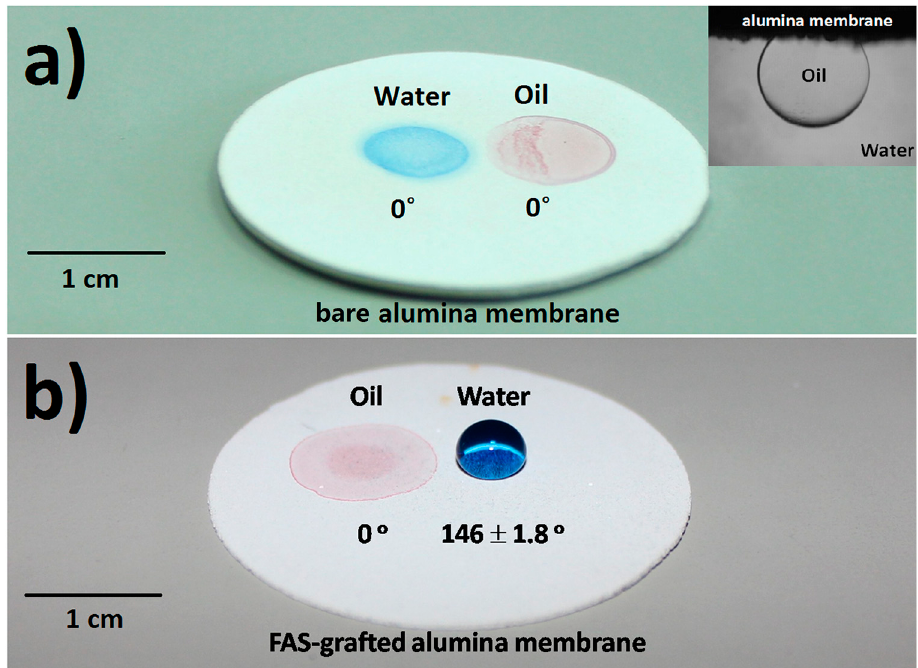
Figure 3. Wetting behavior of water and oil on alumina membranes (top surface). ( a ) Droplets of water (dyed blue, 50 μ L) and oil (octane, dyed red, 50 μ L) on a bare alumina membrane. (Inset) A photograph of an oil droplet (octane, 5 μ L) underwater on a bare alumina membrane. ( b ) Droplets of water (dyed blue) and oil (octane, dyed red) on a fluoroalkylsilane (FAS)-grafted alumina membrane.